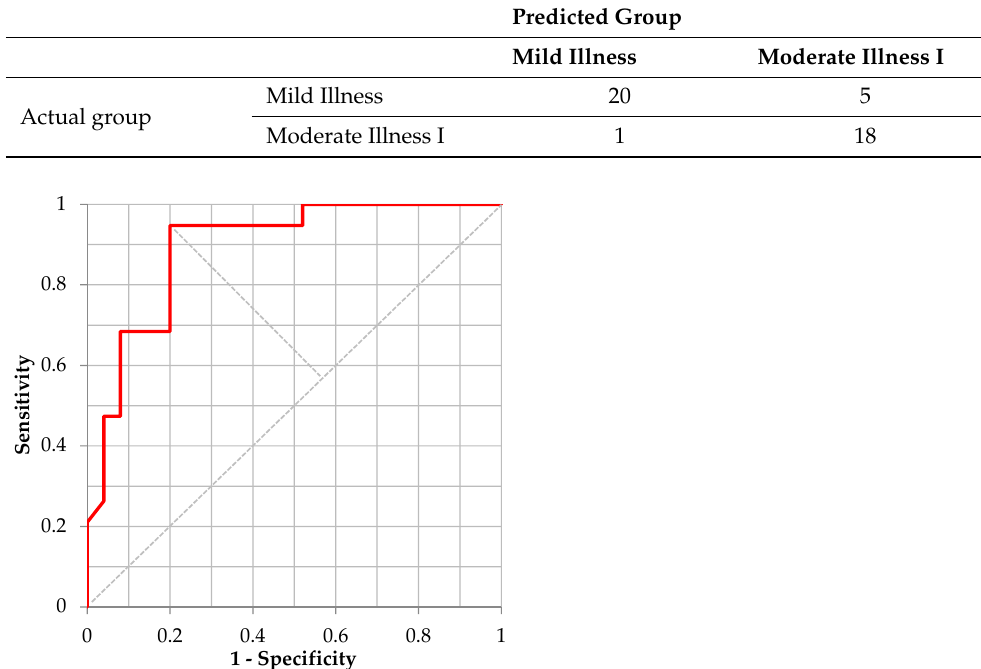
13 Figure 3. ROC curve distinguishing “Moderate Illness 1” using the learning model of /Uh/. Moreover, for distinguishing “Moderate Illness 1” using the ML model for sustained vowels /Ah/, /Eh/, and /Uh/ in combination, Table 12 shows the confusion matrix defined by the cutoff point value from the Youden’s Index and Figure 4 shows the corresponding ROC curve. Regarding the performance of the trained model for /Ah/, /Eh/, and /Uh/, the sensitivity, specificity, accuracy, and AUC were 0.792, 0.947, 0.887, and 0.9320, respec- tively.